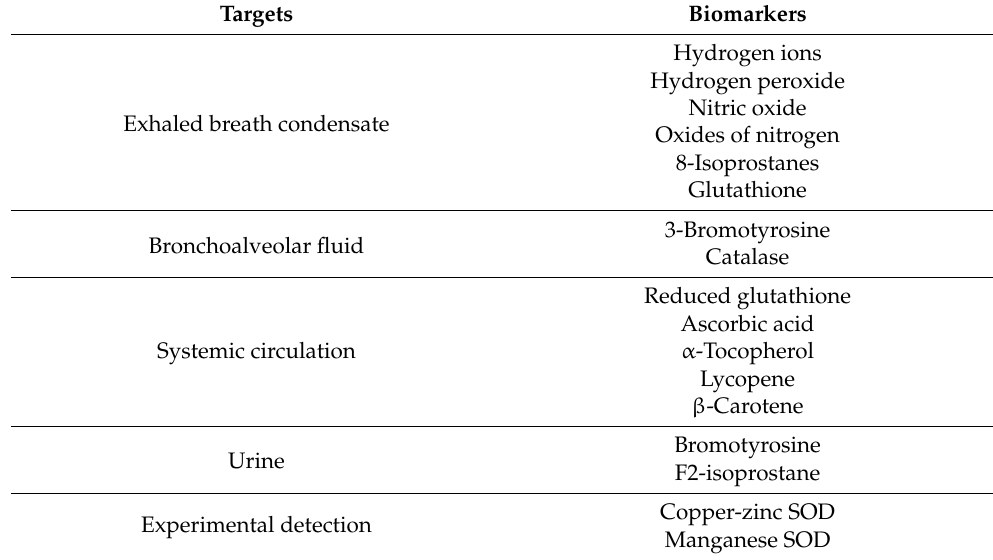
Table 2. Biological targets and biomarkers of oxidative stress in